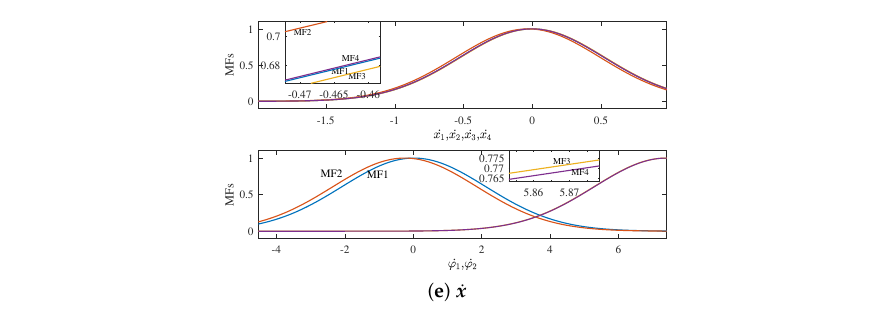
Figure 3. Membership functions generated by subtractive clustering. ( a ) Membership functions of x d ; ( b ) Membership functions of ˙ x d ; ( c ) Membership functions of ¨ x d ; ( d ) Membership functions of x ; ( e ) Membership functions of ˙ x